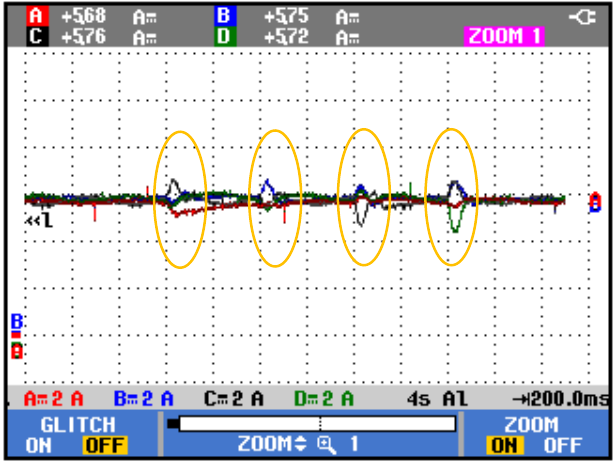
Figure 23. Output currents during sequential current attacks.